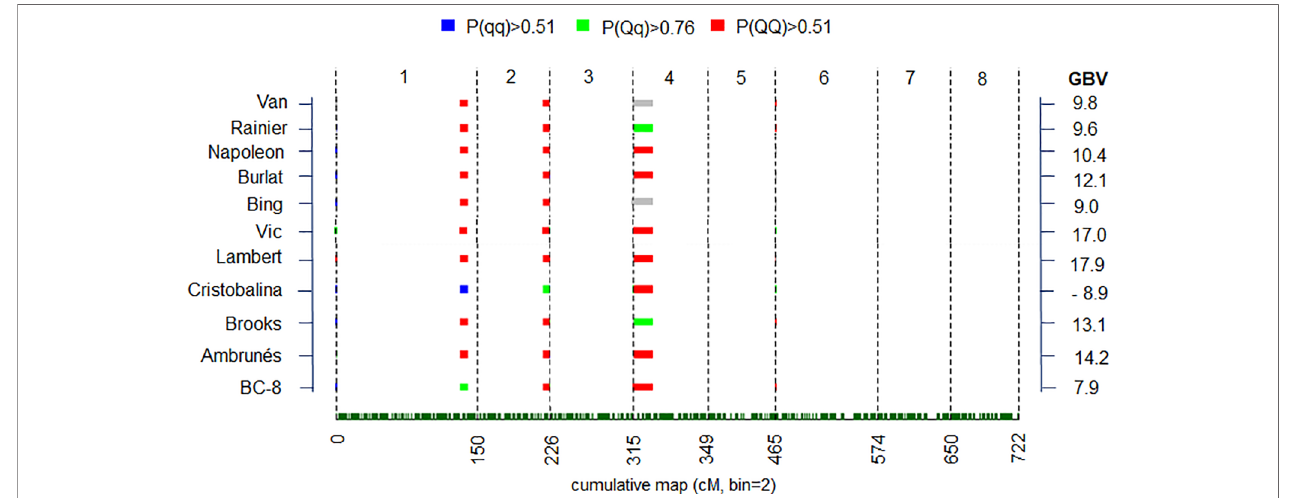
FIGURE 4 | Posterior estimates of parental quantitative trait loci (QTL) genotype probabilities in QTL regions with strong and decisive QTL evidences (2lnBF > 5) for best linear unbiased prediction (BLUP) values. Red, green and blue colors represent positive evidence for QTL genotypes QQ, Qq, and qq genotypes, respectevely. “ Q ” and “ q ” denote alleles with high and low phenotype values, respectively. Gray colors indicate unclear genotype estimation. Genome breeding value (GBV) for each cultivar is indicated at right.